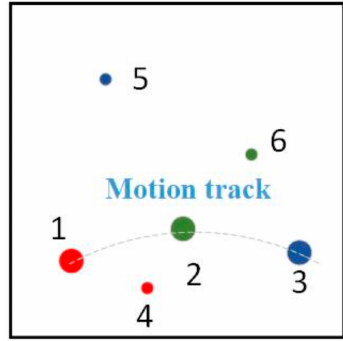
Figure 14. Superimposition of consecutive three sub-apertures (or the three consecutive frames of image from the camera